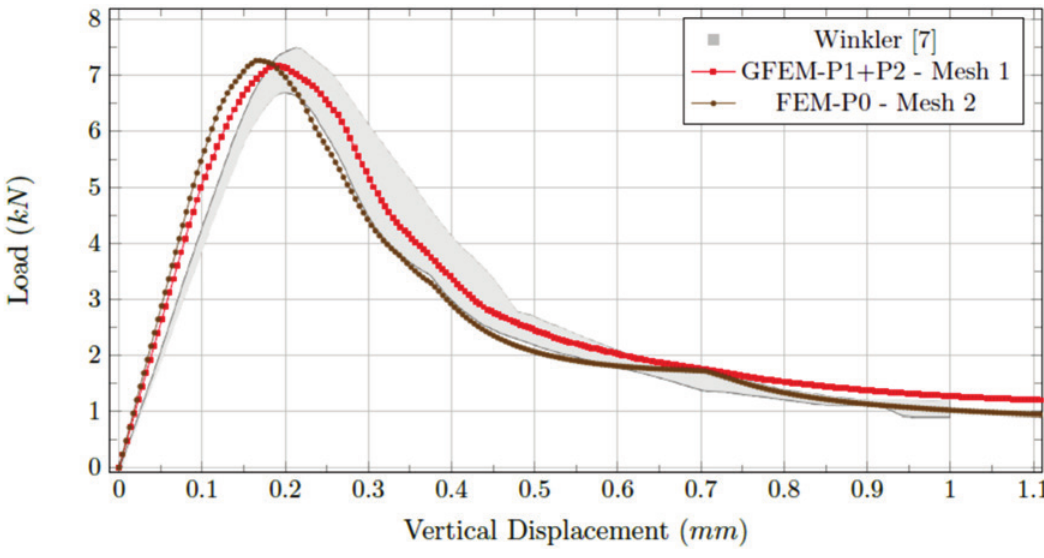
Simulations for L-shaped panel by Winkler et al. [5] using the Microplane Model and an exponential damage law (equation